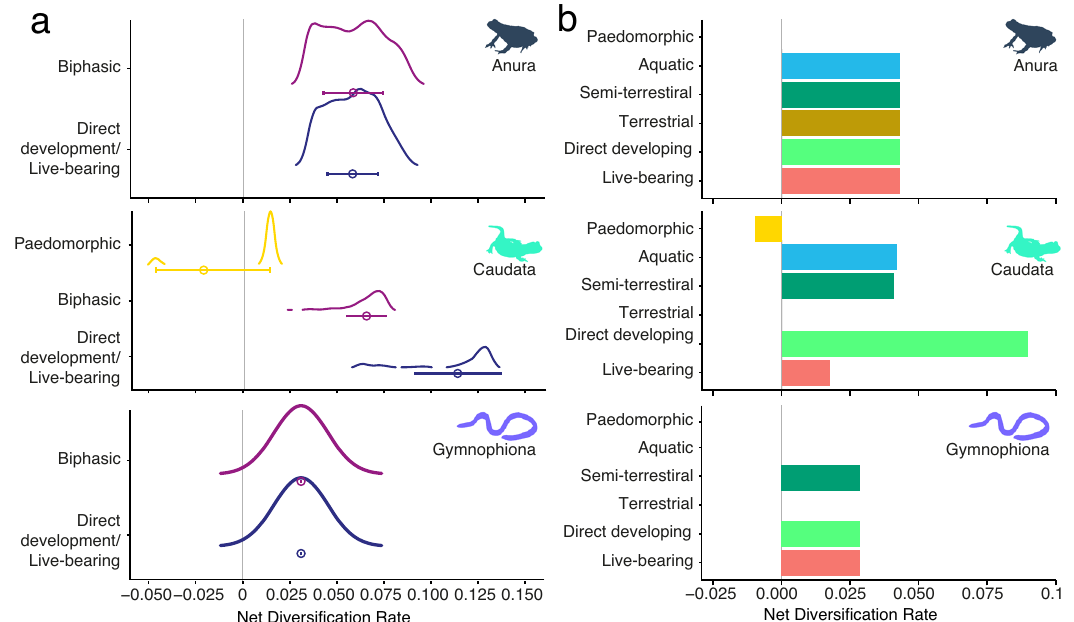
Rate−0.050−0.025 0 0.025 0.050 0.075 0.100 0.125 Net Diversification Fig.4|Netdiversi fi cationrates(speciationminusextinction)perreproductive Diversi fi cation rate model (CD). In cases where models contained hidden states, modes for Anura, Caudata and Gymnophiona. a Distributions (with standard ratesareweightedaveragesperspecies. b Diversi fi cationrateestimatesforeachof the six reproductive modes, where blue=aquatic; dark green=semi-terrestrial; deviation error bars around the mean) of rates estimated per species in the phy- brown=terrestrial; light green=direct development; red=live-bearing; yellow= logeny for each life-cycle category (i.e., tip rates). Species are categorized into paedomorphism. Estimates are calculated using the best- fi tting secsse models, biphasic life cycles (dark magenta), direct development (dark blue) or paedo- which for Anurawasa Reproductive modeIndependent Diversi fi cation rate model morphism(yellow).Samplesizes(where n =numberofspecies)foreachareAnura: (RmID) with hidden states, for Caudata was a Reproductive mode dependent biphasic=2608, direct development=755; Caudata: biphasic=192, direct devel- Diversi fi cation model (RmDD) with hidden states, and for Gymnophiona was a opment=320, paedomorphism=34; Gymnophiona: biphasic=19, direct develop- Constant Diversi fi cation rate model(CD).In caseswhere modelscontained hidden ment=43. Estimates were calculated using the best- fi tting hisse models, which for states, rates shown are averaged across hidden and observed states. Icons in both Anura was a Reproductive mode Independent Diversi fi cation rate model (RmID) panels distinguish the three amphibian groups. Source data are provided as a with hidden states, for Caudata was a Reproductive mode dependent Diversi fi ca- Source Data fi tion rate model (RmDD) with hidden states, and for Gymnophiona was a Constant